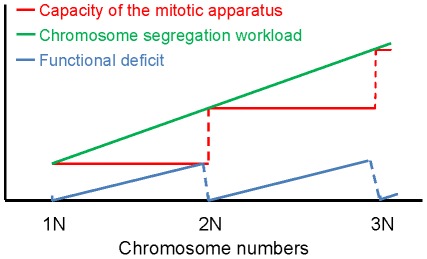
Model of discrete scaling of the functionality of the mitotic system.Schematic representation of the chromosome segregation workload (green), the capacity of the mitotic system for accurate chromosome segregation (red), and the overall functional deficit (blue) of the mitotic system (the difference between workload and mitotic capacity) as a function of increasing number of chromosome in the genome (see Discussion). The model is based on the assumption that the mitotic system increases its functionality via discrete steps only when a full set of chromosomes is gained, whereas the segregation workload increases linearly with the number of chromosomes. The resulting functional deficit explains why hypo-diploid strains are in general more chromosomally unstable than hyper-haploid strains as observed. Further studies will be required to verify whether this trend extends also to cells with a ploidy between 2N and 3N.